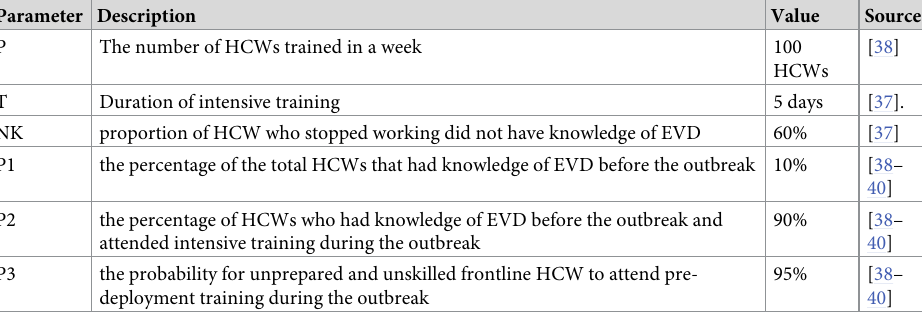
Table 2. Parameters for the hybrid model (education